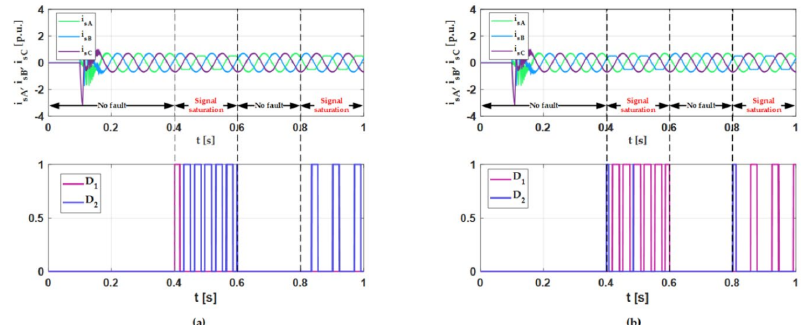
Figure 13. Phase currents under signal saturation in phase A ( a ), B ( b ) and detector responses in scalar control structure.